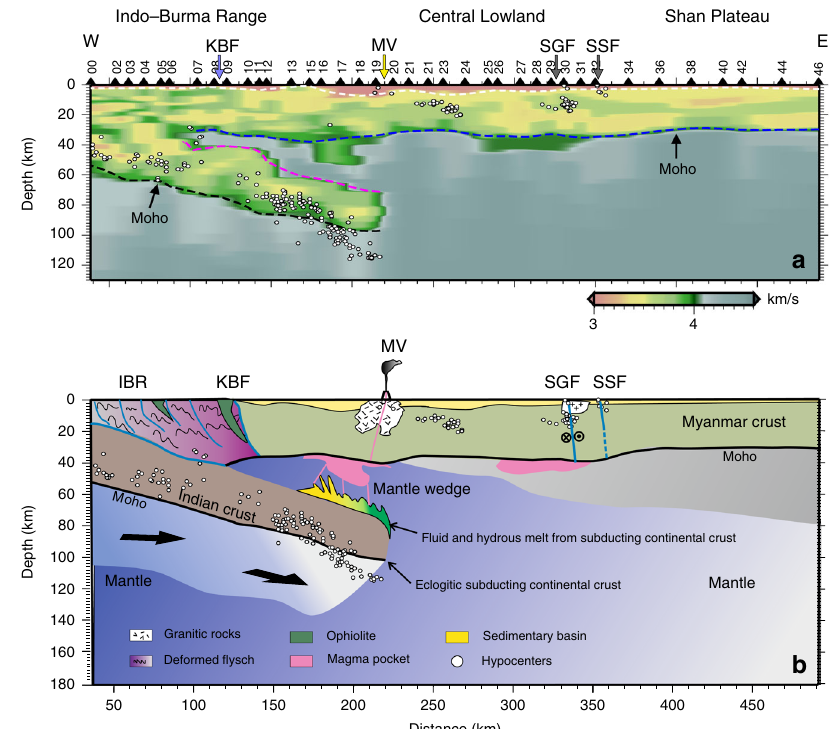
Fig. 5 Shear wave velocity structure and related schematic model. a Shear wave velocity structures of the crust and uppermost mantle compiled from the velocity models resulting from waveform inversion beneath each station along the CMSP. The values of shear velocity are indicated by the color bar at the bottom of the map. The white dashed line represents the basement interface, and the blue dashed line indicates the depth of the Moho along the pro fi le. The dipping crustal segment in the mantle is bounded by the magenta and black dashed lines. White dots denote the newly located shallow and intermediate-depth earthquakes, and only the earthquakes located within 0.25° of the pro fi le are shown here. b Schematic model of Indian continental subduction tectonics beneath Myanmar. White dots denote the newly located shallow and intermediate-depth earthquakes, which are the same as those